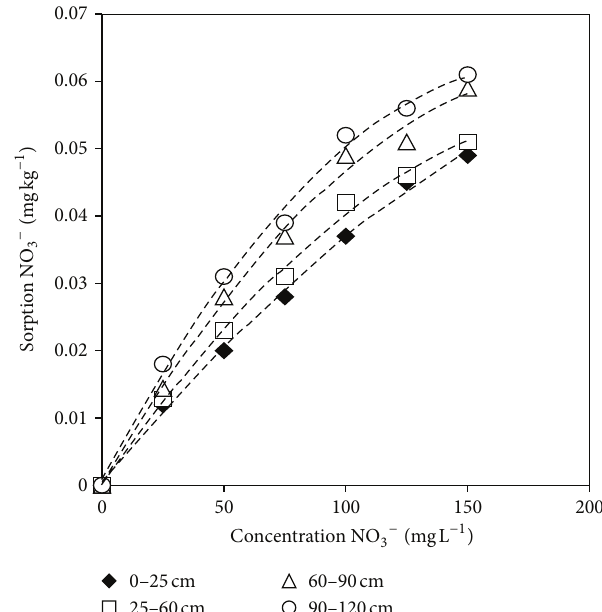
Concentration NO 3− (mg L −1 )